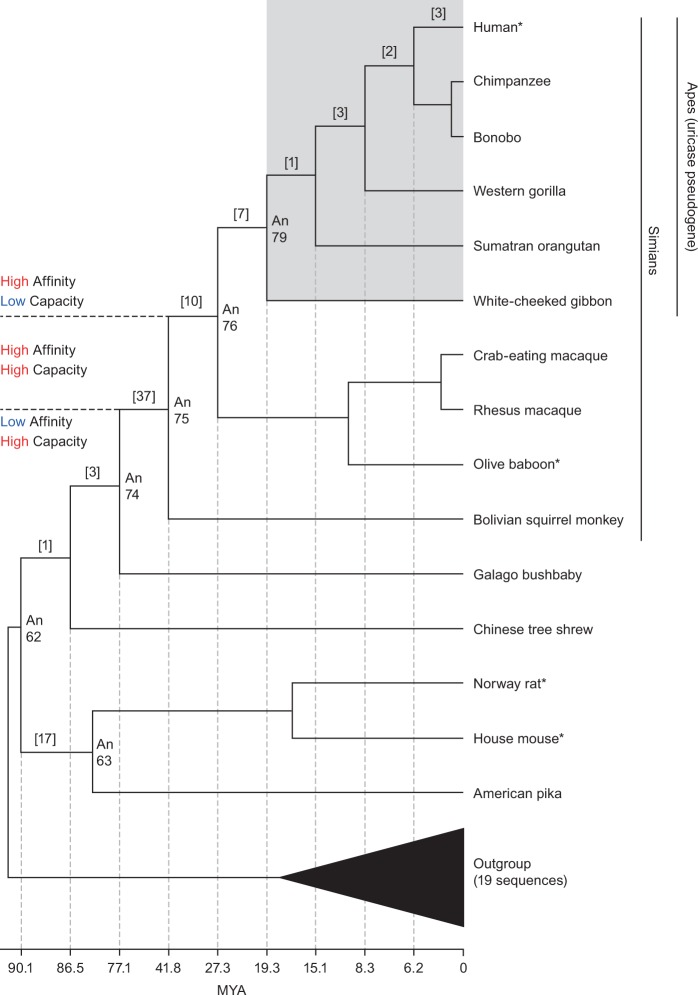
Phylogeny of the URAT1 transporter family and properties of modern and inferred ancestral transporters. Shown is a phylogenetic tree depicting the evolutionary relationships that focus on the Euarchontoglires portion URAT1 phylogeny. The nodes for which ancestral sequences were inferred and synthesized in the laboratory are labeled with the prefix of “An.” Modern transporters assayed in this study have an asterisk. The ape clade is boxed in gray and labeled to note the absence of functional uricase enzymes in this URAT1 phylogeny. The number of amino acid replacements between any two nodes is bracketed. Additional rodents/lagomorphs were used for evolutionary analyses but not shown in this simplified tree (supplementary fig. S3, Supplementary Material online). Divergence times for ancestral nodes are provided along the horizontal plane (Hedges et al. 2015). Color corresponds to values from table 1.